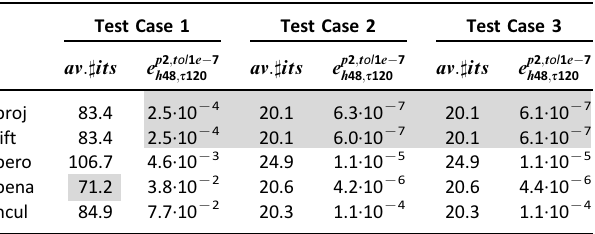
Table 4. (Performance of GMRES within various formulations, see section GMRES performance ) The averaged number of iterations per time-step av :] its and the approximation error for several methods and all three test cases for N h ¼ 48, N s ¼ 120, and quadratic elements ( cg ¼ 2 ) in the case that the resulting linear equations are solved using GMRES up to a relative residual of tol ¼ 10 (cid:3) 7